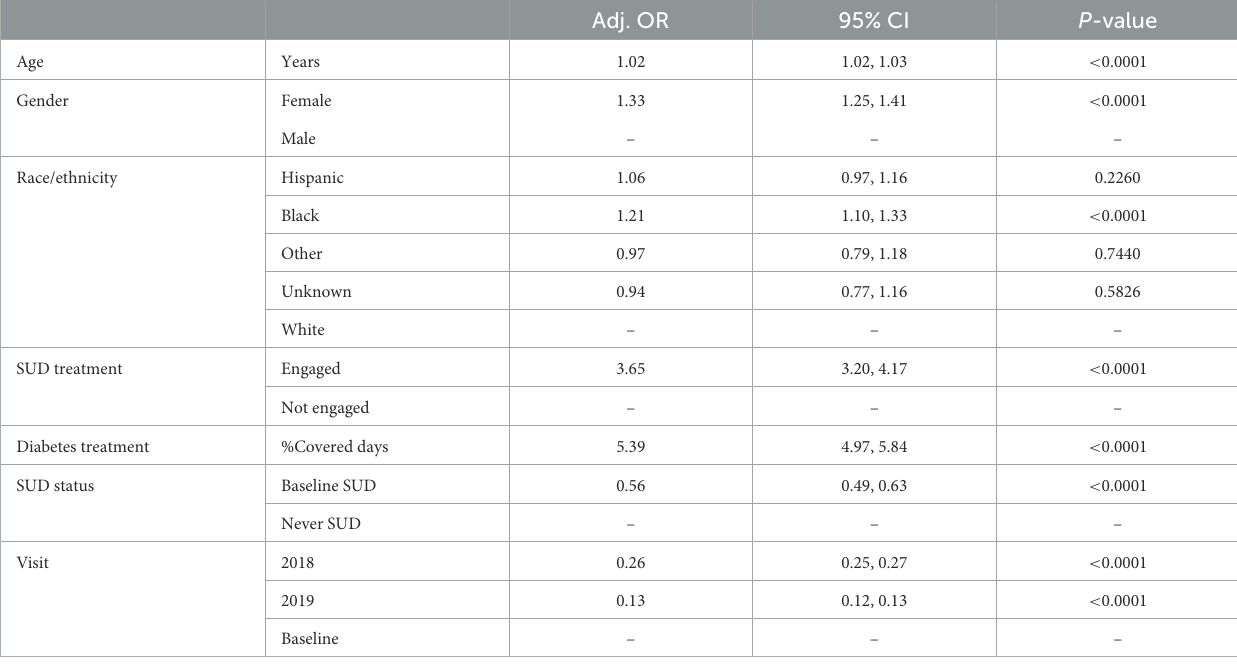
TABLE 2 Generalized linear mixed models (GLMM) results: substance use disorder status as a predictor of HbA1c control 2016–2019 among HCN patients with type 2 diabetes.